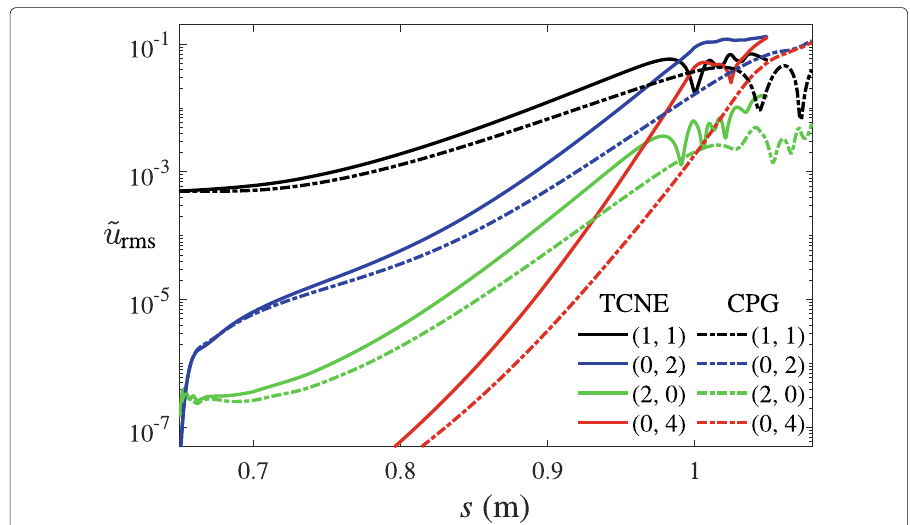
Fig. 13 Streamwise development of representative waves in the oblique-mode breakdown with f = 500kHz and k c = 20 for the TCNE and CPG